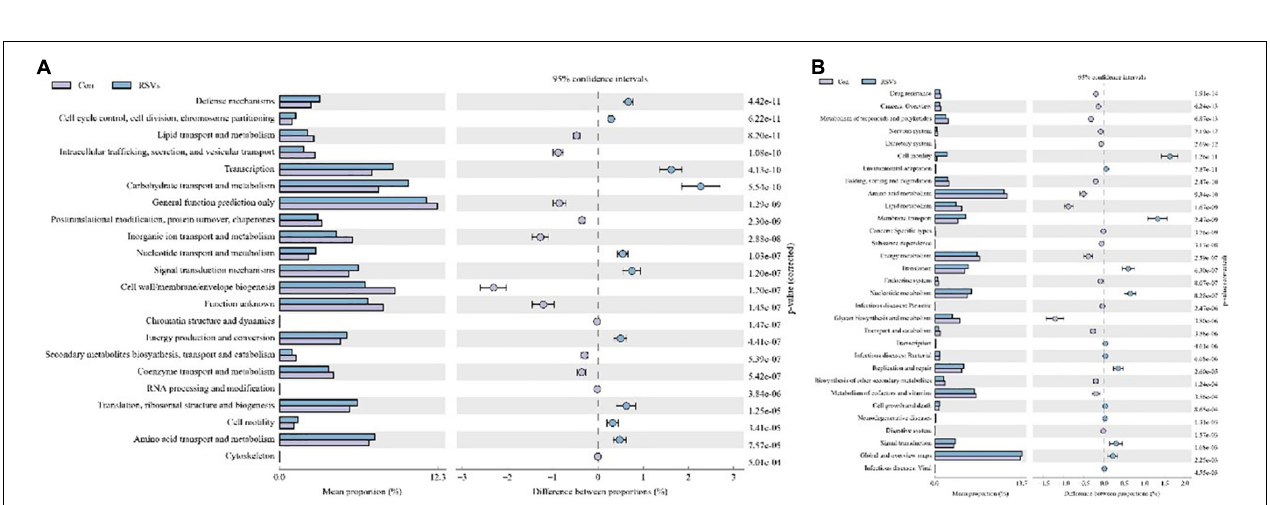
FIGURE 8 | Effect of RSV on the bacterial communities in the cecum content of weaned mice at the genus level. Con = control group, RSV10 = 10 mg/kg RSV, RSV20 = 20 mg/kg RSV, RSV50 = 50 mg/kg RSV. *Means with single asterisks are significantly different ( p < 0.05) from values of control group, and **means with double asterisks are extremely significant different ( p < 0.01) from values of control group.